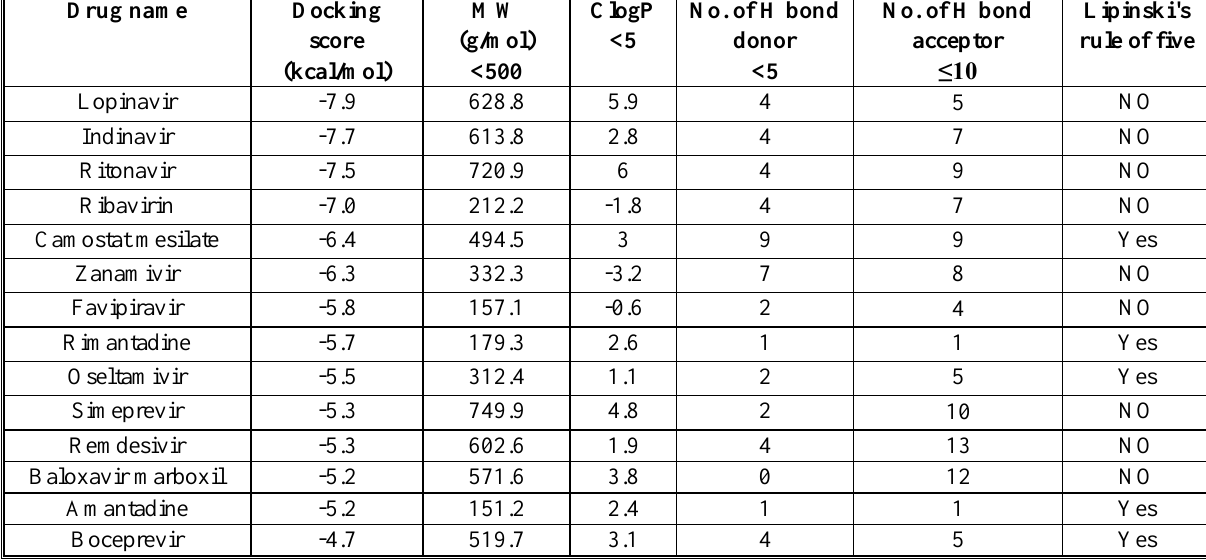
Figure 6. Molecular docking of lopinavir has interacted with COVID-19 main protease enzyme Table 2 . The docking score (kcal/mol), MW, CLogP, No. of H bond donor, No. of H bond acceptor, and Lipinski’s rule of five for FDA approved